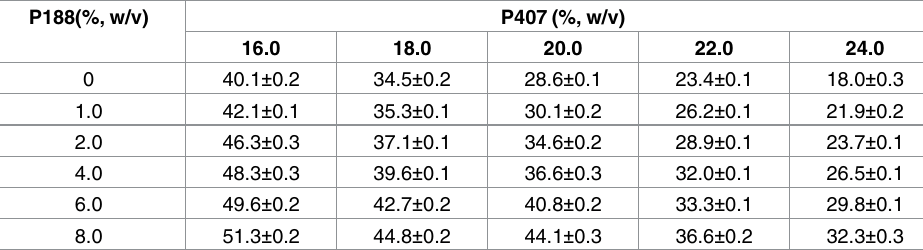
Table 1. Effects of P188 and P407 concentration on the gelation temperature (n = 3, ˚C). P188(%,